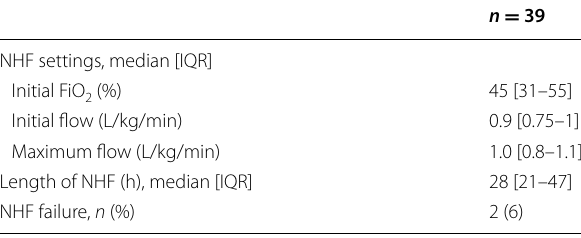
Table 2 Nasal high flow (NHF) parameters of 39 children treated for status